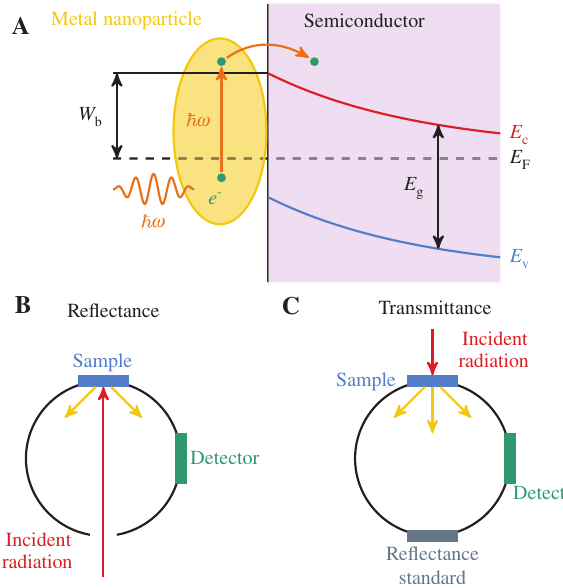
Figure 1: Illustration of the NP electron emission mechanism (A) and illustration of the working principle of the integrating sphere for reflectance (B) and transmittance (C) measurements,